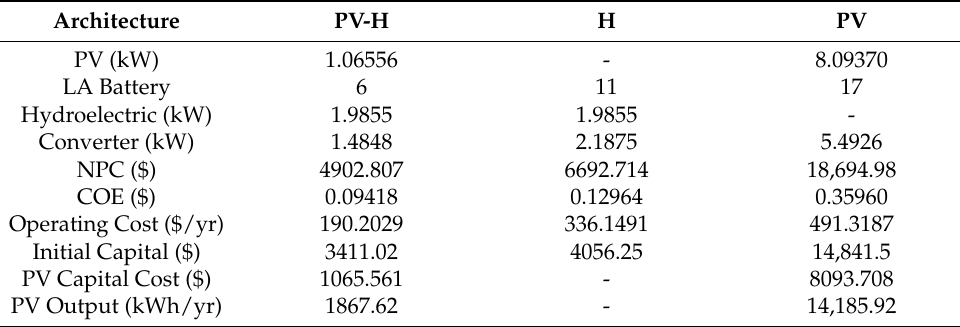
Table 5. Optimized hybrid renewable energy architectures.